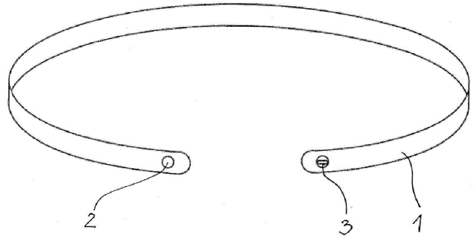
Figure 3. Drawing of the flexible exhaled breath analyzer based on the developed gas sensor substrates: (1) substrate, (2) gas-inlet port, (3) electronic port